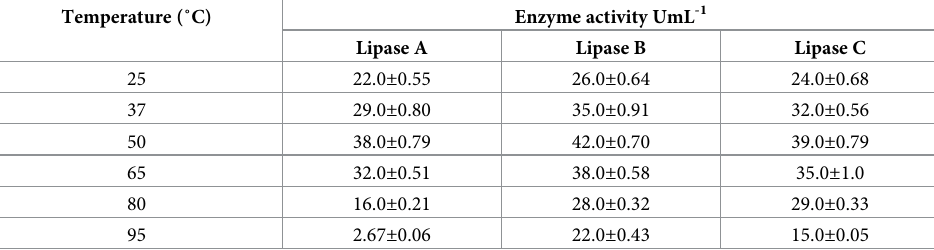
Table 3. Effect of temperature on lipase production from B . cereus NC7401 cultured using starch (Lipase A), malt- ose (Lipase B), and tryptone (Lipase C).